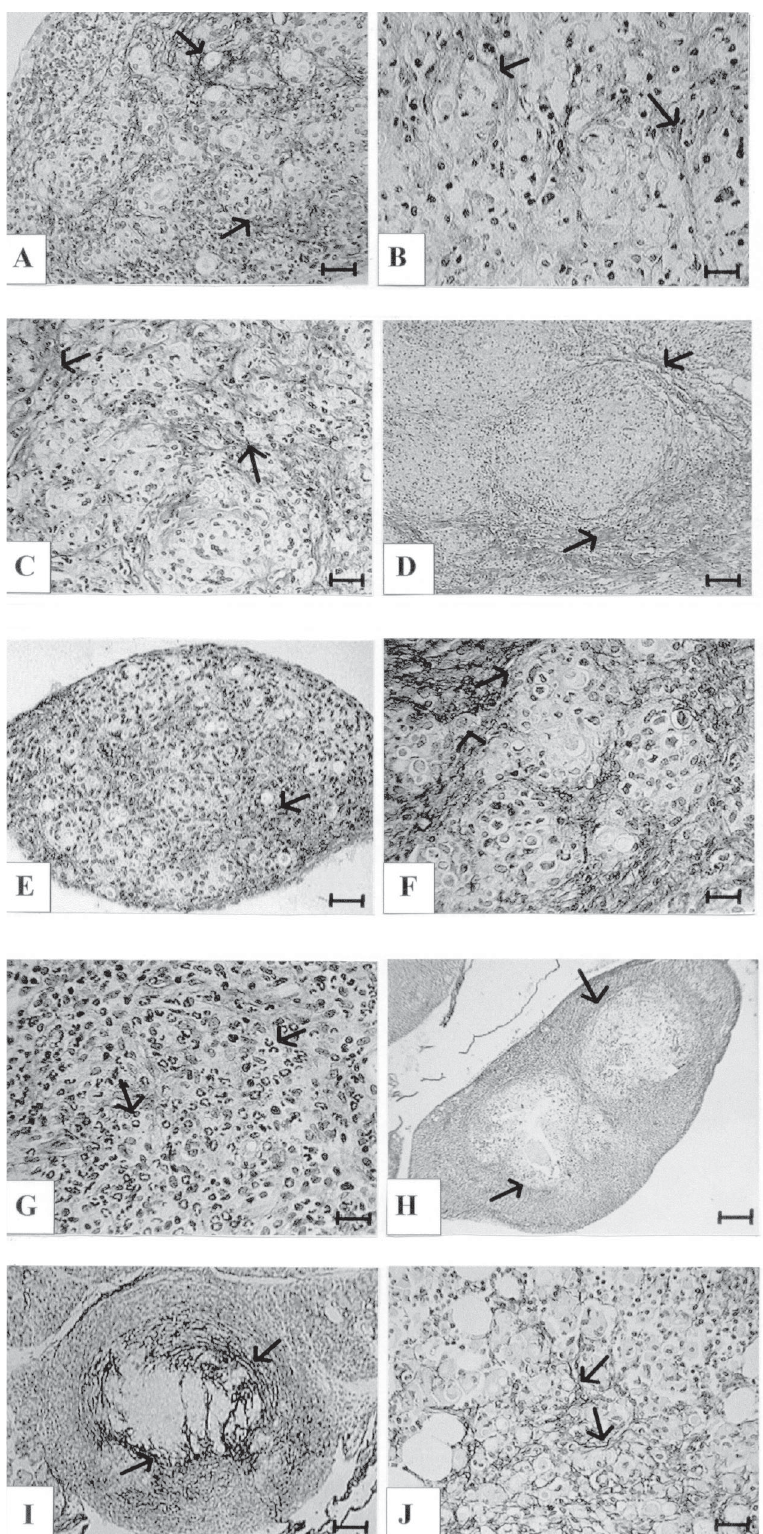
Figure 2. Immunohistochemical analysis of decorin in granulomatous lesions. A , Positive reaction in the ex- tracellular matrix (ECM) around small granulomatous foci (arrows) in susceptible mice at 15 days after infec- tion (bar = 31.25 µm). B , Positive loose lesion (arrows) in susceptible mice at 30 days after infection (bar = 25 µm). C , Decorin staining around small granulomas (ar- rows) in susceptible mice at 120 days after infection (bar = 31.25 µm). D , Extensive lesions with lesser deposition of decorin (arrows) around various granulo- matous foci in susceptible mice at 150 days after infec- tion (bar = 50 µm). E , Milky spot (arrow) stained in resistant mice at 15 days after infection (bar = 31.25 µm). F , Macrophages (arrowhead) and giant cells (ar- row) surrounded by positively stained ECM in resistant mice at 30 days after infection (bar = 25 µm). G , Nega- tive reaction in the cellular components (arrows) in resistant mice at 30 days after infection (bar = 25 µm). H , Necrotic area (arrows) in resistant mice at 120 days after infection (bar = 125 µm). I , Encapsulated lesion with a fibrotic area (arrows) enclosed by decorin in resistant mice at 150 days after infection (bar = 50 µm). J , Positivity around pseudoxanthomatous macrophages (arrows) in a residual lesion in resistant mice at 150 days after infection (bar = 31.25 µm). Streptavidin-biotin-per- oxidase reaction; original magnifications: 40X (H); 100X (D and I); 250X (A, C, E and J); 400X (B, F and